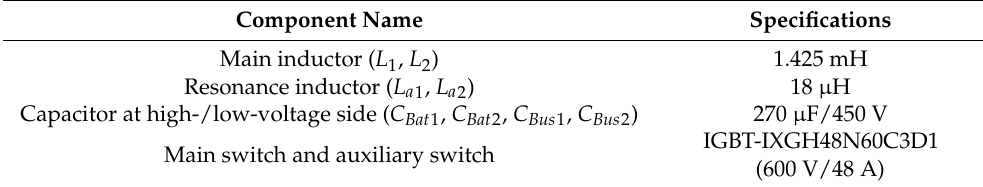
Table 2. The component parameters of the bidirectional buck–boost soft-switching